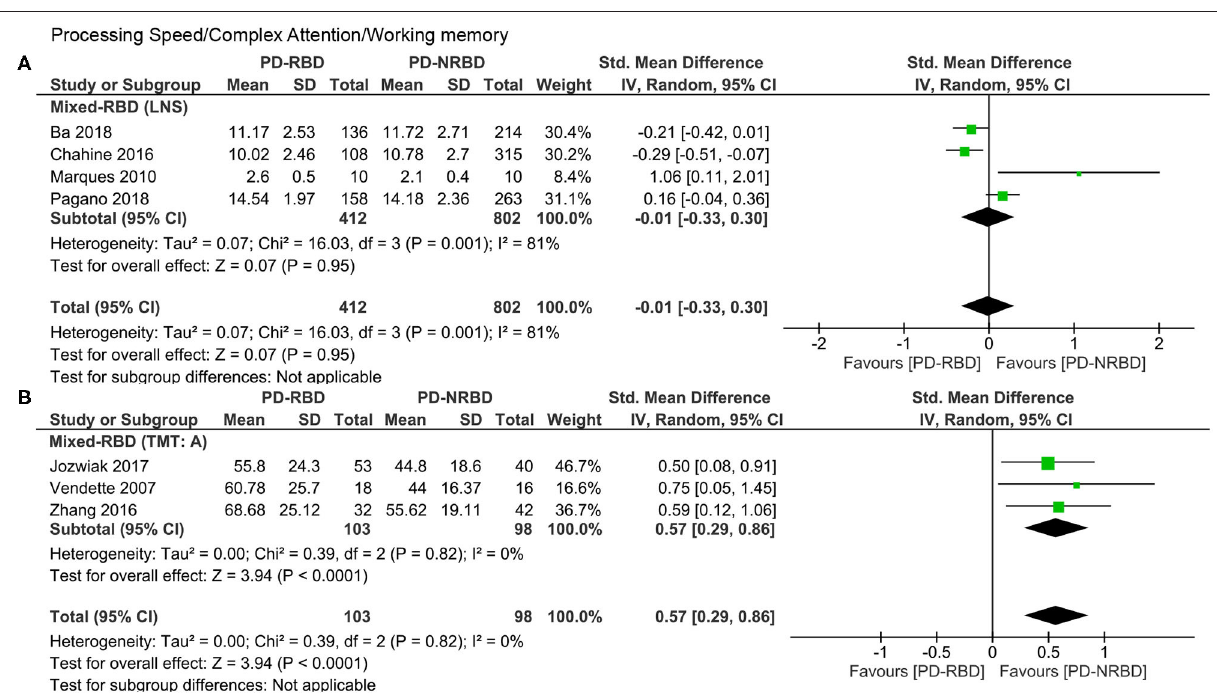
FIGURE 6 | Forest plot for processing speed/complex attention/working memory evaluated by the (A) LNS and the (B) TMT: A displaying effect size calculated using a random-effects model. SD , standard deviation; Std. Mean Difference , standardized mean difference; CI , confidence interval; LNS , letter–number sequence; TMT: A , trail making test, part